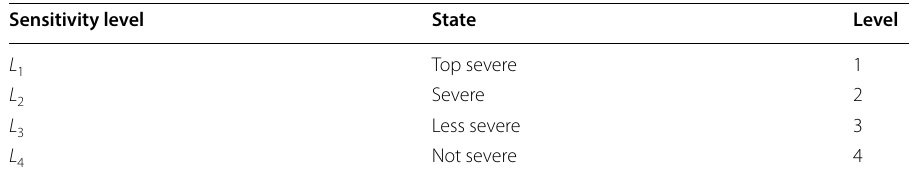
Table 3 Level of sensitivity Sensitivity level